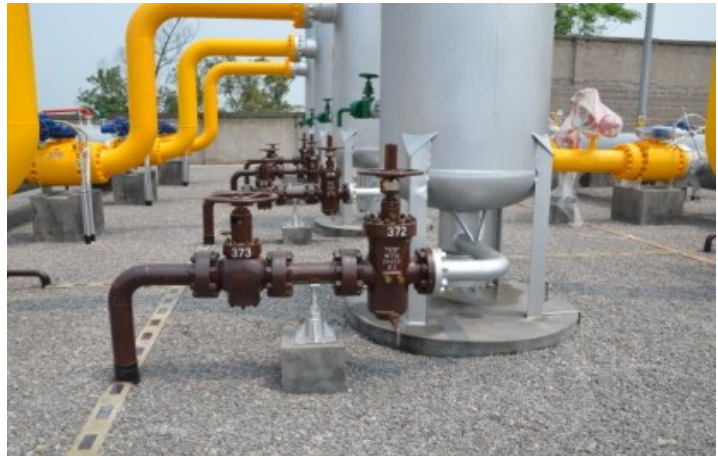
Figure 2. Gas–solid two-phase flow pipeline erosion physical model.